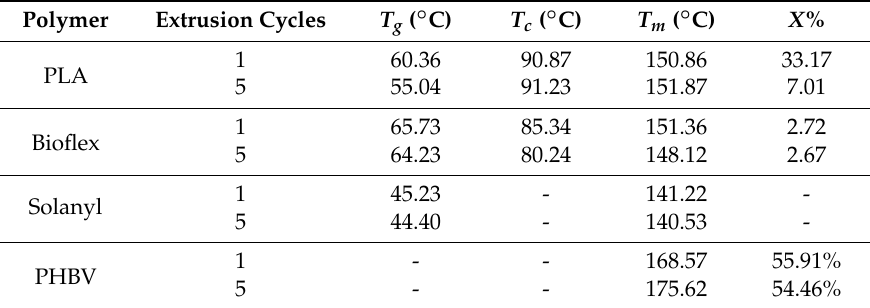
Figure 4. Representative DSC analysis curve of virgin and recycled polymers. Table 5. Evaluation of the thermal properties of polymers as a function of the recycling process.